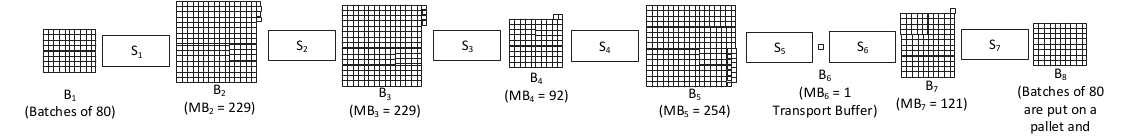
Fig. 8(a). Serial production line